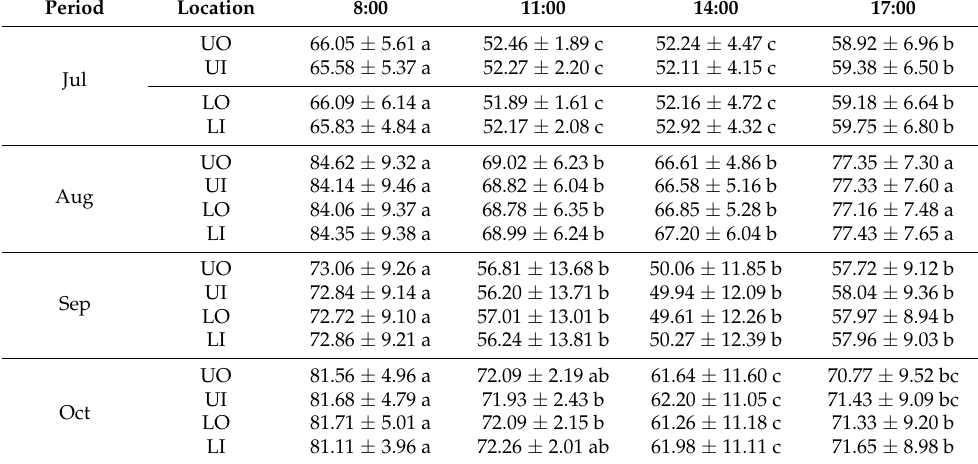
Data are represented as the mean values ± standard deviation (SD; n = 6). Different uppercase and lowercase letters indicate significant differences ( p ≤ 0.05; Duncan’s multiple range tests) between locations and times, respectively. Table 2. The variations of relative humidity (%) at different times of the day in canopies.